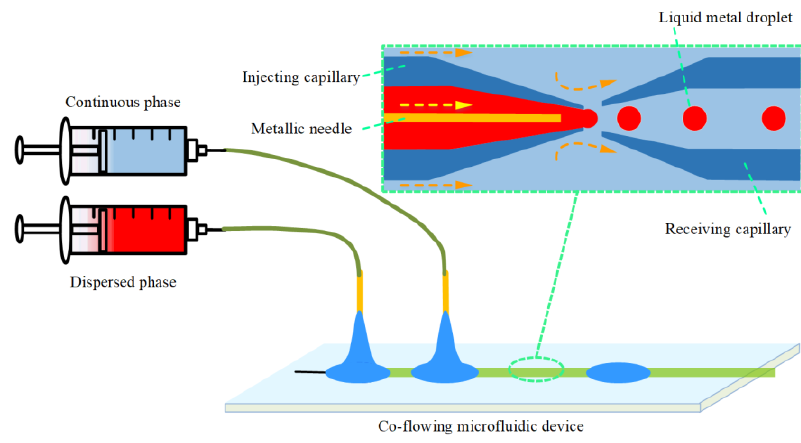
Figure 1. Schematic of the micro-needle induced co-flowing microfluidic experimental setup.